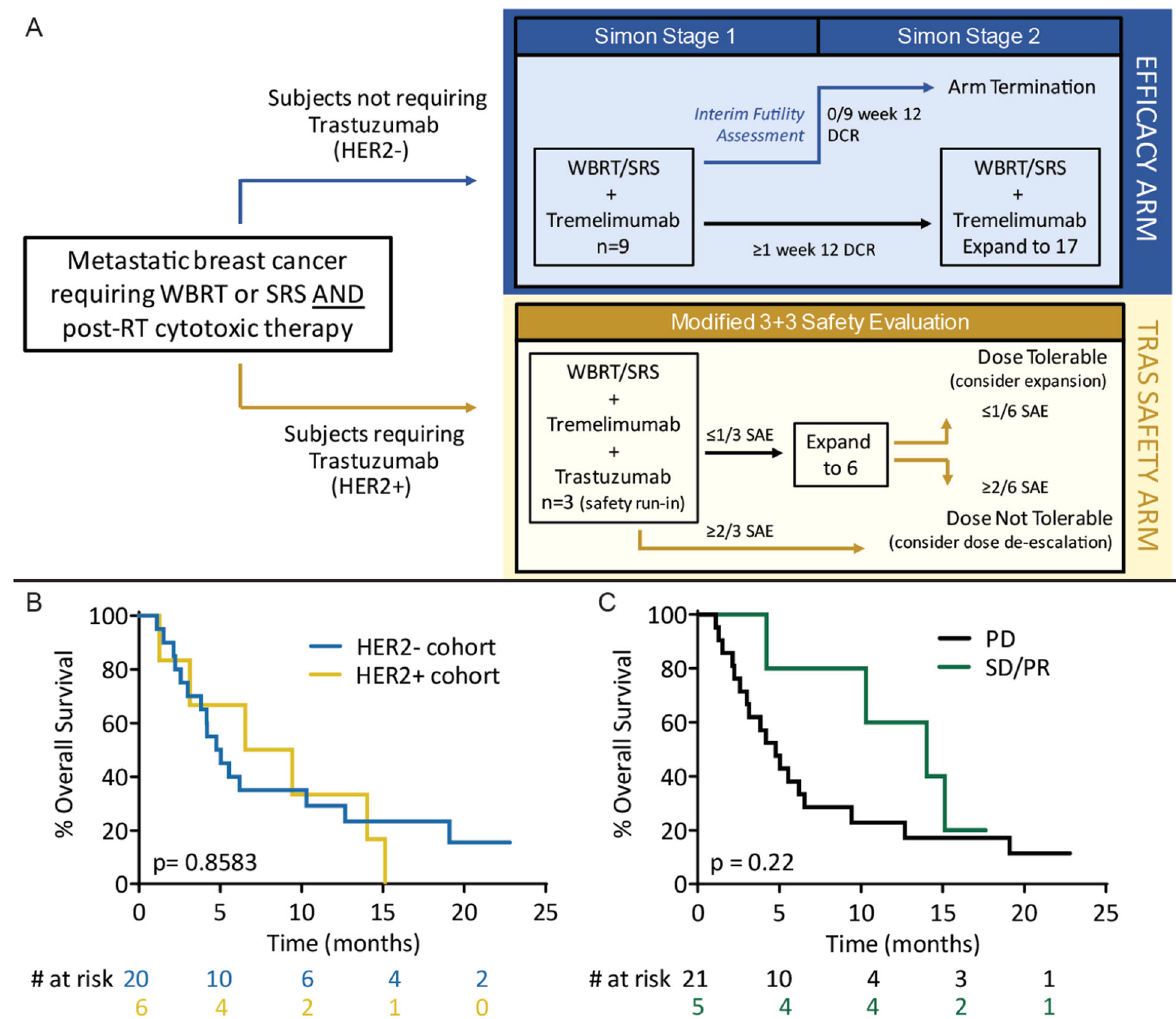
Fig. 1 Trial schema and overall survival. A Trial design showing Simon two-stage design for the HER2 − cohort and the safety evaluation for the HER2 + cohort. Three or more DCR responses in 17 patients at the end of the study for the treatment to be considered meritorious for further investigation. However, three additional subjects enrolled in the HER2 − cohort to expand sample size for estimation of DCR at week 12. These subjects were not included in the pre-speci fi ed primary ef fi cacy determination. B Median OS for HER2 − cohort = 4.9 months, median OS for HER2 + cohort = 7.98 months. C Median OS for patients with PD = 4.47 months, median OS for patients with SD or PR = 14.58